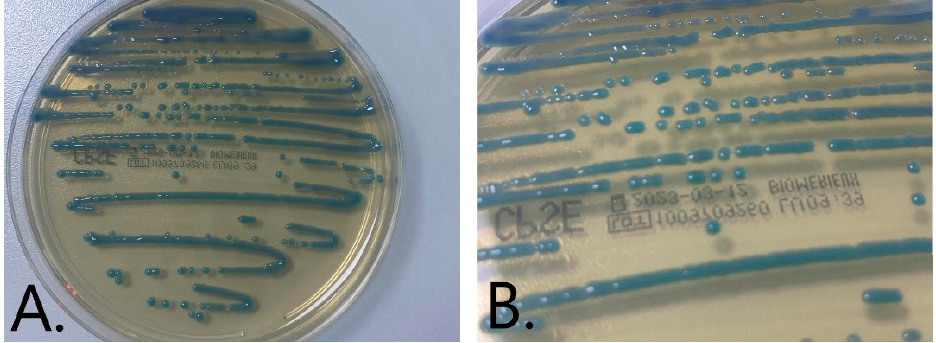
Figure 2. ( A , B ) Isolated green-to-blue colonies on chromID CPS Elite (bioMérieux) medium from the primary culture.